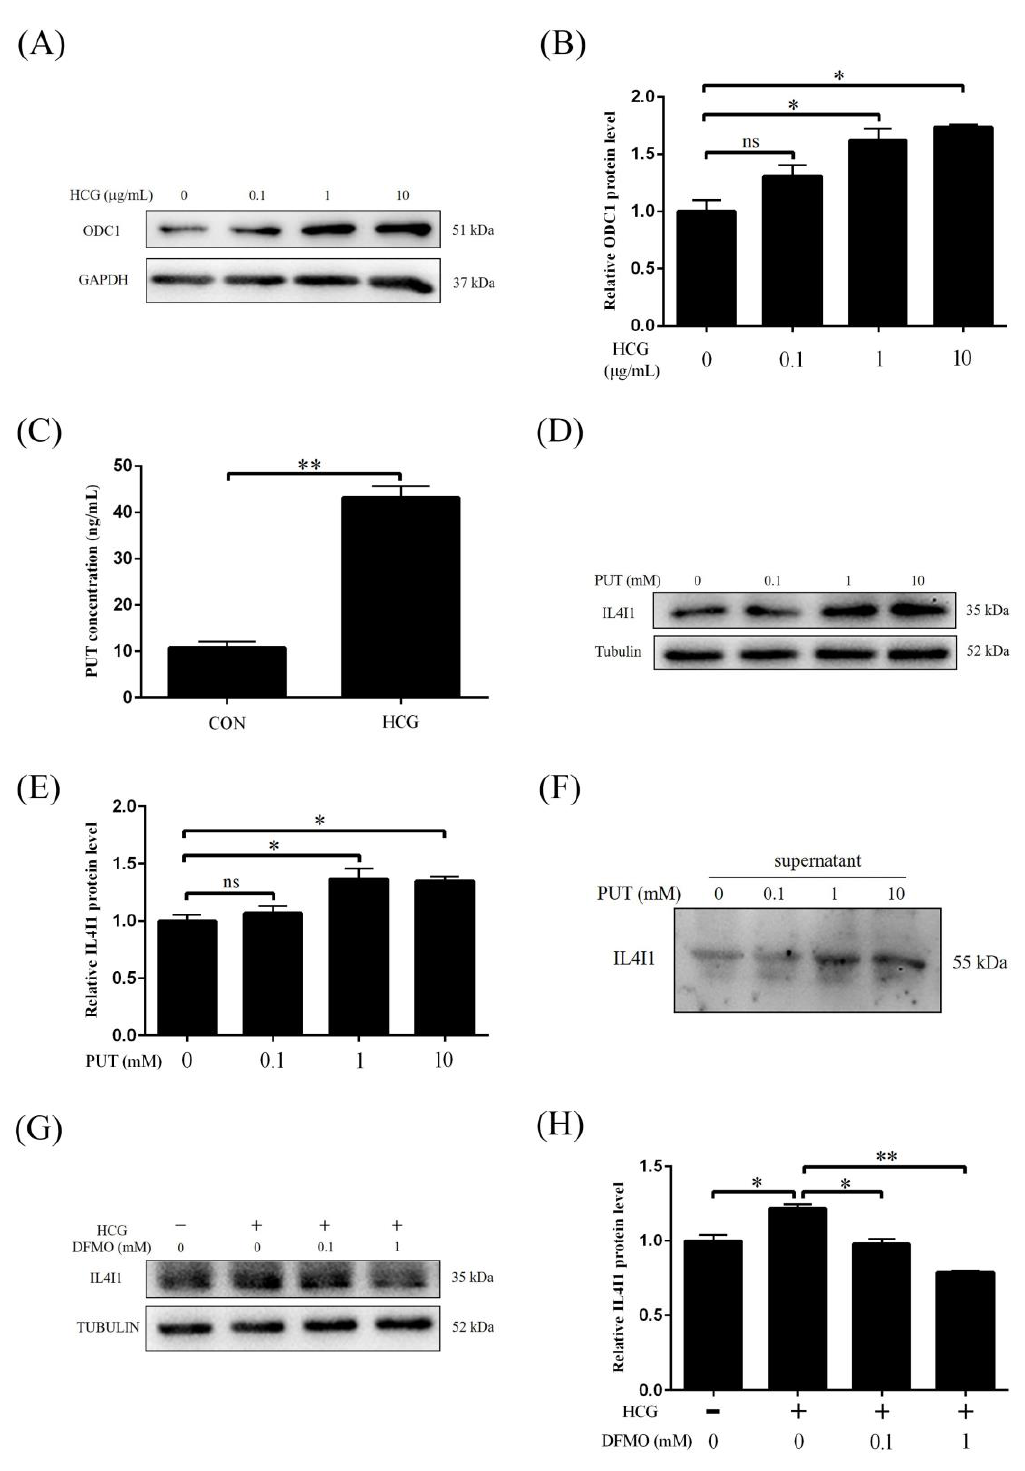
Figure 7. HCG regulates IL4I1 expression through polyamine metabolism. ( A , B ) Effects of different concentrations of HCG on the ODC1 protein level in Ishikawa cells. ( C ) PUT concentrations after Ishikawa cells were treated with 10 μ g/mL HCG. ( D , E ) Western blot analysis of effects of PUT on IL4I1 expression in Ishikawa cells. ( F ) The effects of PUT on IL4I1 protein secretion in the supernatant of cultured Ishikawa cells. ( G , H ) Western blot analysis of the protein level of IL4I1 after Ishikawa cells were treated with HCG and DFMO. PUT, putrescine; DFMO, difluoromethylornithine. ns, no significance. *, p < 0.05; **, p <